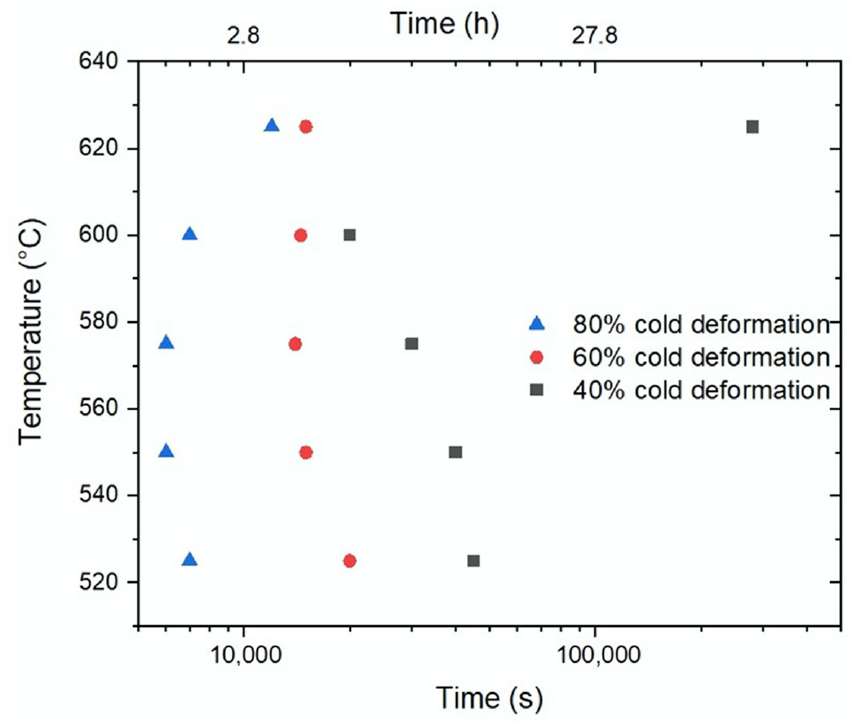
Figure 10. Temperature vs. time to 0.1 vol% (Fe,Mn) 3 C Figure 10 . Temperature vs. time to 0.1 vol% (Fe,Mn) 3 C precipitation.